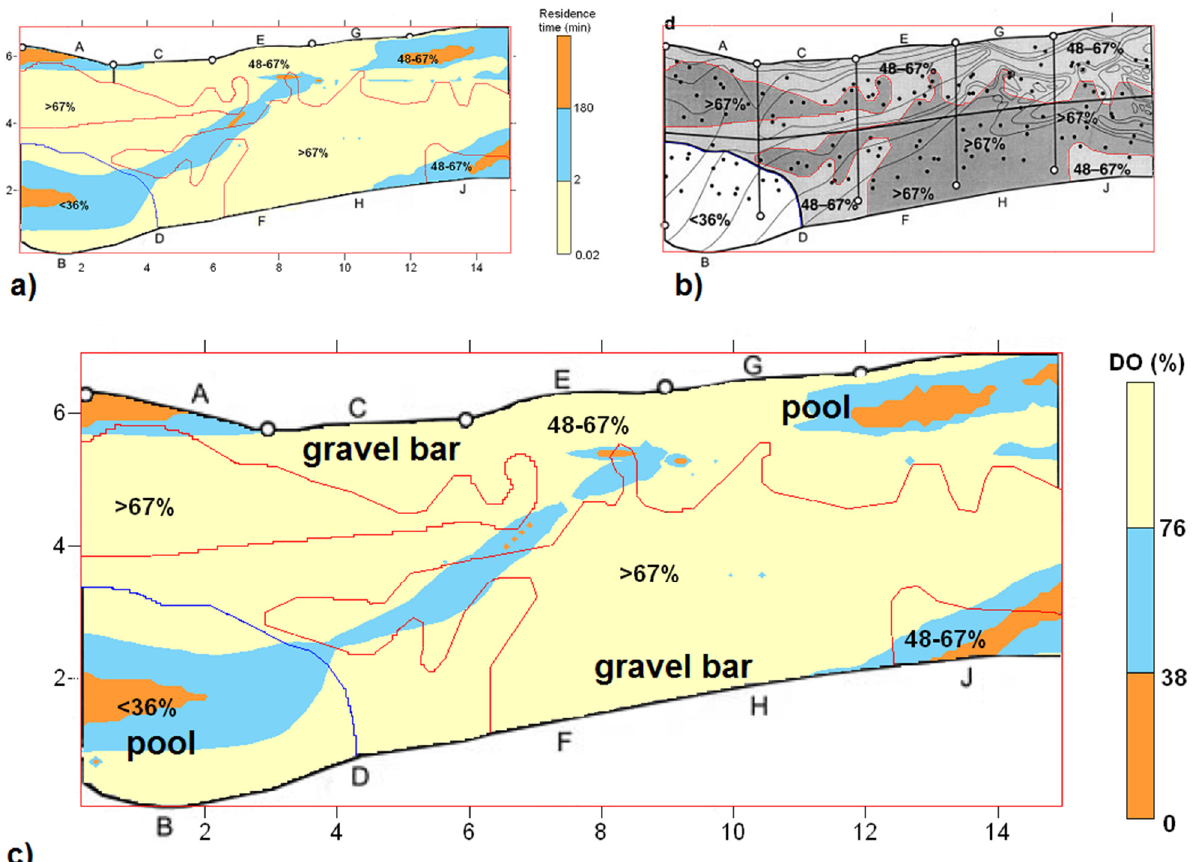
Figure 3. Maps of: ( a ) the computed residence time distribution of water within the hyporheic zone, τ up ; ( b ) the measured dissolved oxygen concentrations, (DO), in % of saturation reproduced from Figure 4d in Malard et al. [41]; and ( c ) the model-predicted DO along the 15-m reach of the Lachein